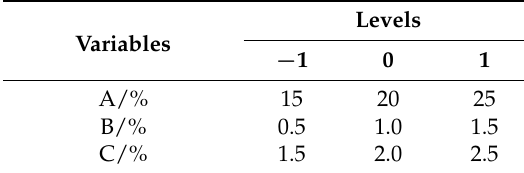
Table 2. Independent variables and the corresponding levels in central composite design.